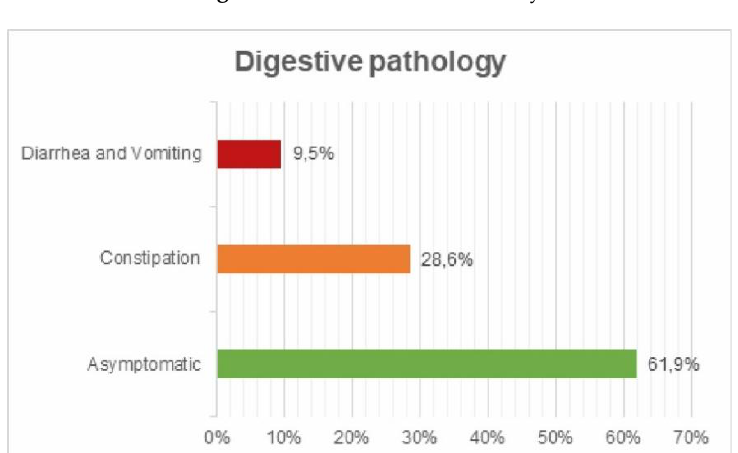
Figure 11. Digestive pathology survey.